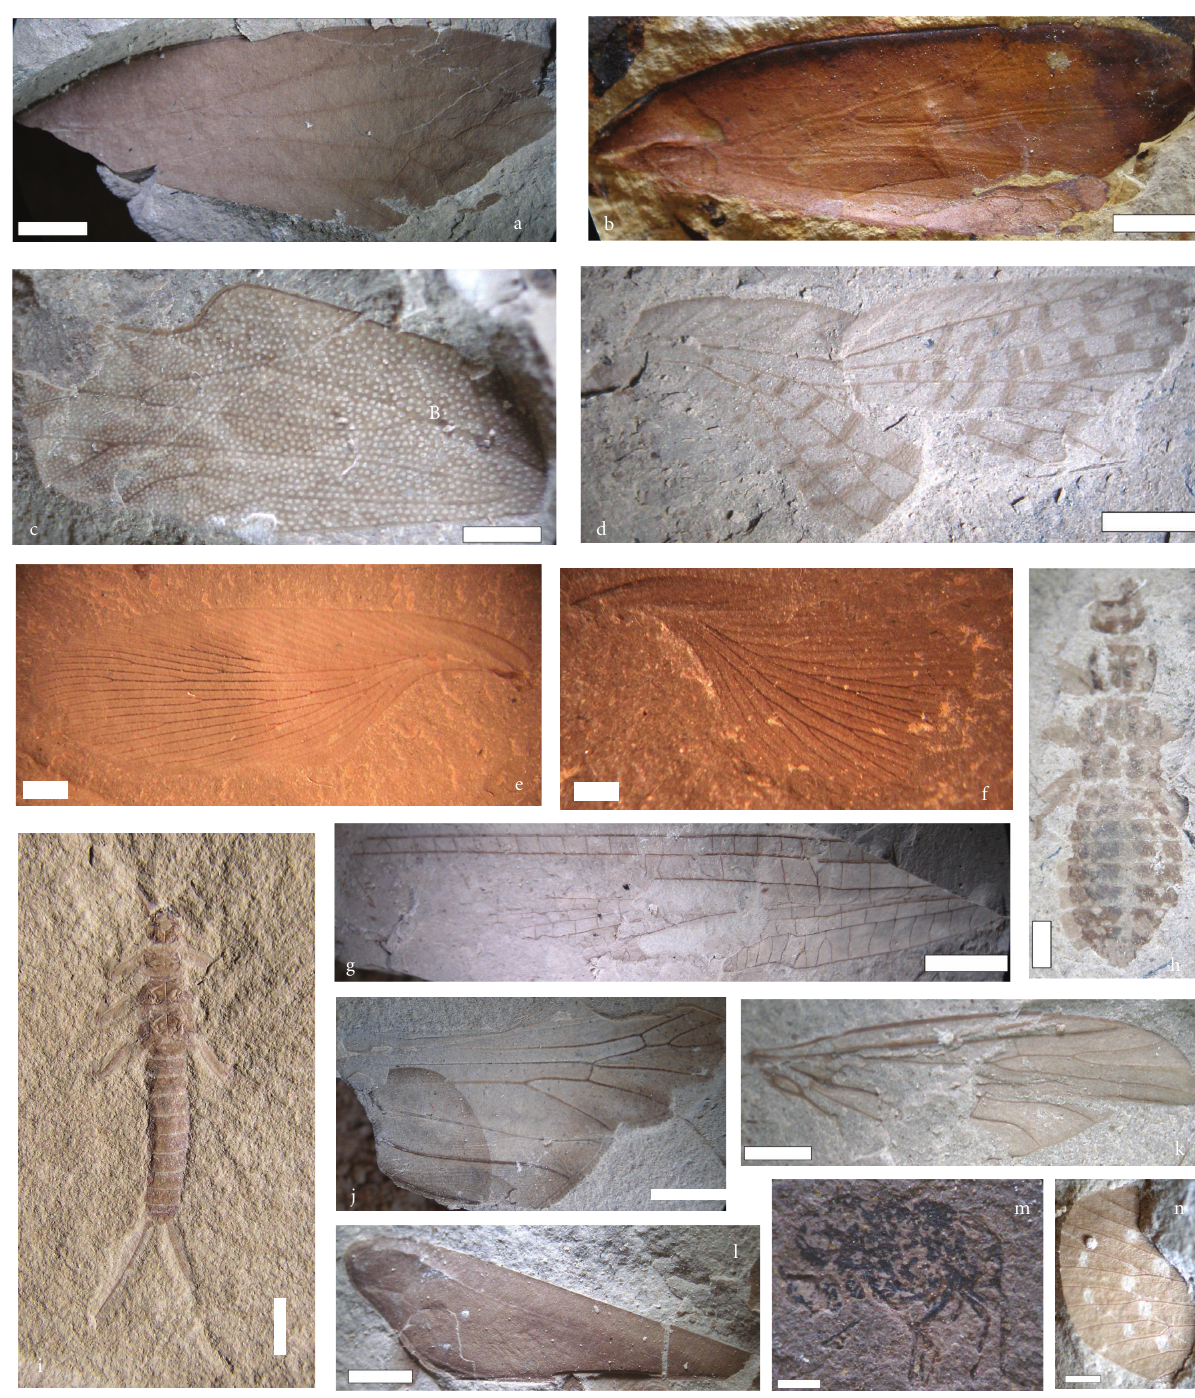
Figure 6: Examples of fossil insects collected from Triassic insects localities, Western Argentina, illustrating its diversity and the stage of preservation (impression) seen in the localities. (a), band (c): Hemiptera. (d): Orthoptera. (e): Mancusoblatta pulchellaand (f): Hermosablatta crassatella (Blattida), Martins-Neto et al., [45]. (g) and (h): Odonata adult and nymph, respectively. (i): Platyperla marquati (nymph), Gallego et al., [54]. (j), (k), (m), and (n): indet. material. l: Hemiptera clavus. Scale bar: 1mm (except (a), (b), (c), and (i):